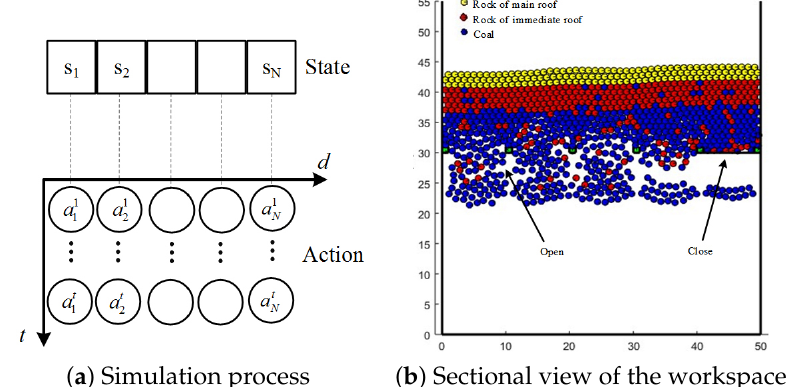
Figure 2. simulation platform of top-coal caving. In ( a ), The s i , a t action of agent i on the time point t . In ( b ), a number of rock and coal particles distribute randomly in the boundary of rock and coal. Our aim is to obtain the maximum coal with minimum rock by opening and closing the windows.